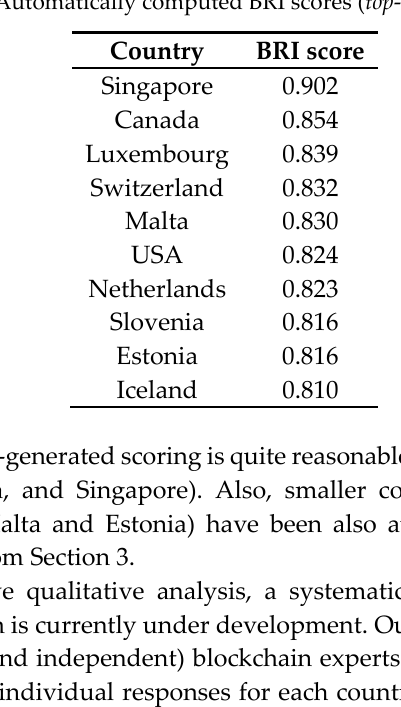
Table 1. Automatically computed BRI scores ( top -ten